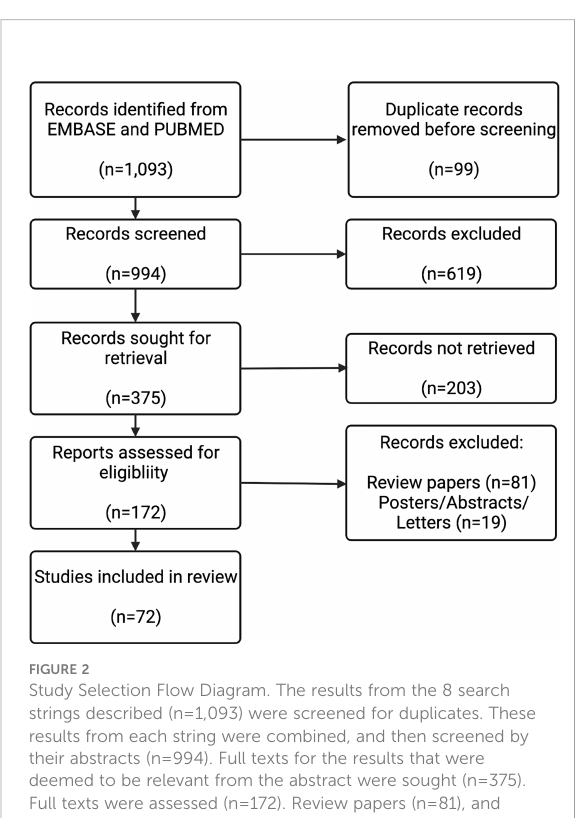
FIGURE 2 Study Selection Flow Diagram. The results from the 8 search strings described (n=1,093) were screened for duplicates. These results from each string were combined, and then screened by their abstracts (n=994). Full texts for the results that were deemed to be relevant from the abstract were sought (n=375). Full texts were assessed (n=172). Review papers (n=81), and posters/abstracts/letters (n=19) were excluded. 72 full-text records were included in this